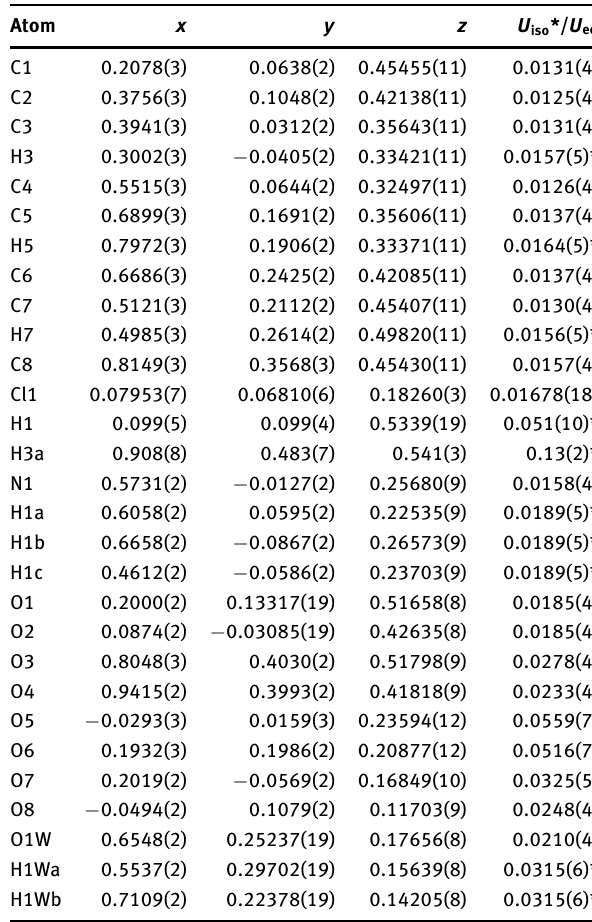
Table 2: Fractional atomic coordinates and isotropic or equivalent isotropic displacement parameters (Å 2